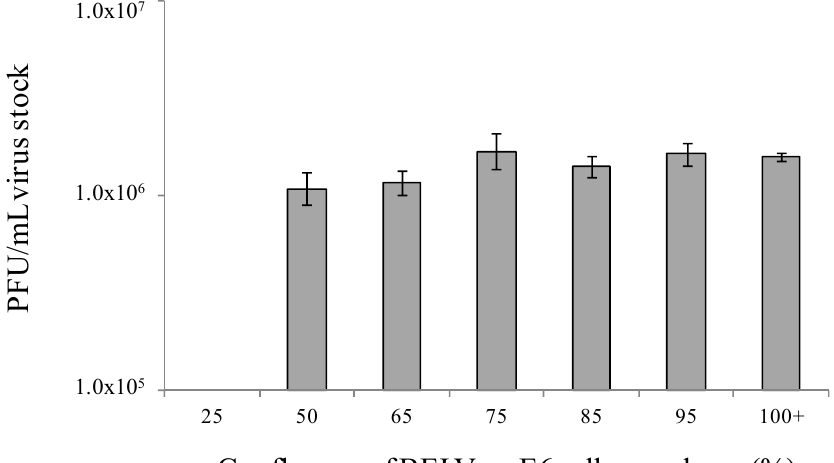
Figure 4. A wide range of monolayer confluencies returns a similar EBOV titer. This experiment was performed by three independent operators with similar results, and one representative graph is shown. Bars represent an average of 5